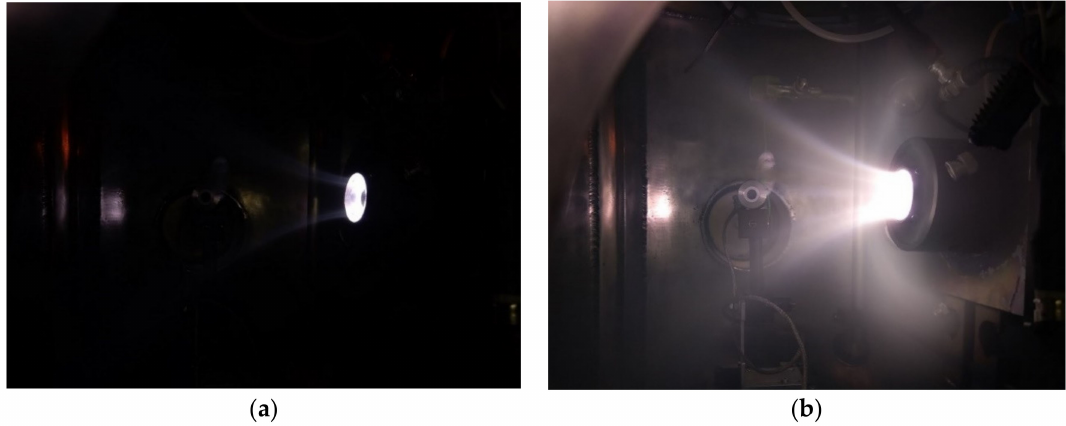
Figure 16. Thruster operation ( a ) at 35 sccm propellant flow and ( b ) at 55 sccm propellant flow. Pictures are made with same camera